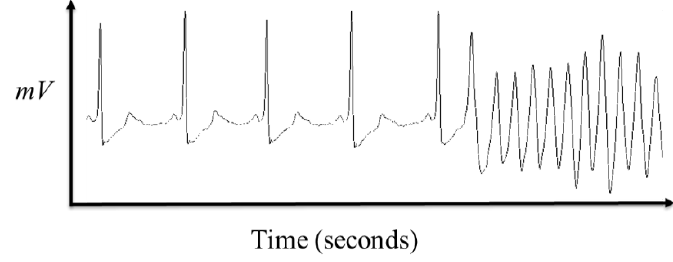
Figure 5. The turning point between a sinus rhythm and the VF event.